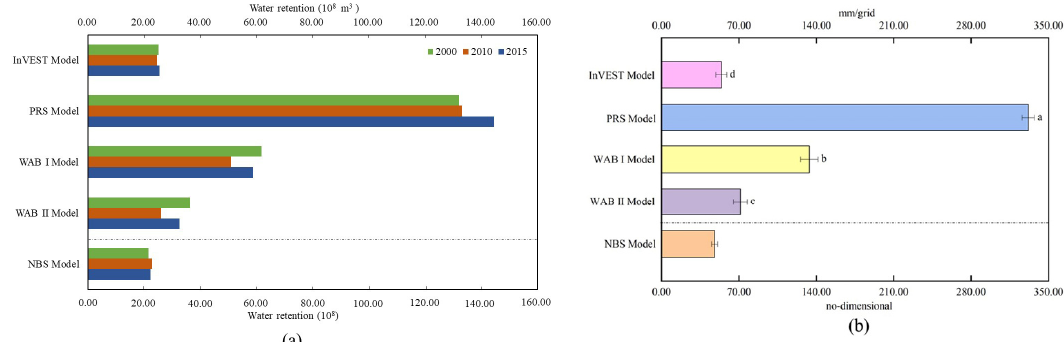
Figure 6. Characteristics of water retention volume or capability by five methods from 2000 to 2015. The units for the InVEST, PRS, WAB I, and WAB II models are m 3 , and dimensionless for the NBS model ( a ). The values are the mean ± standard error, and lowercase letters indicates significant differences among the different models ( p < 0.05) ( b ).